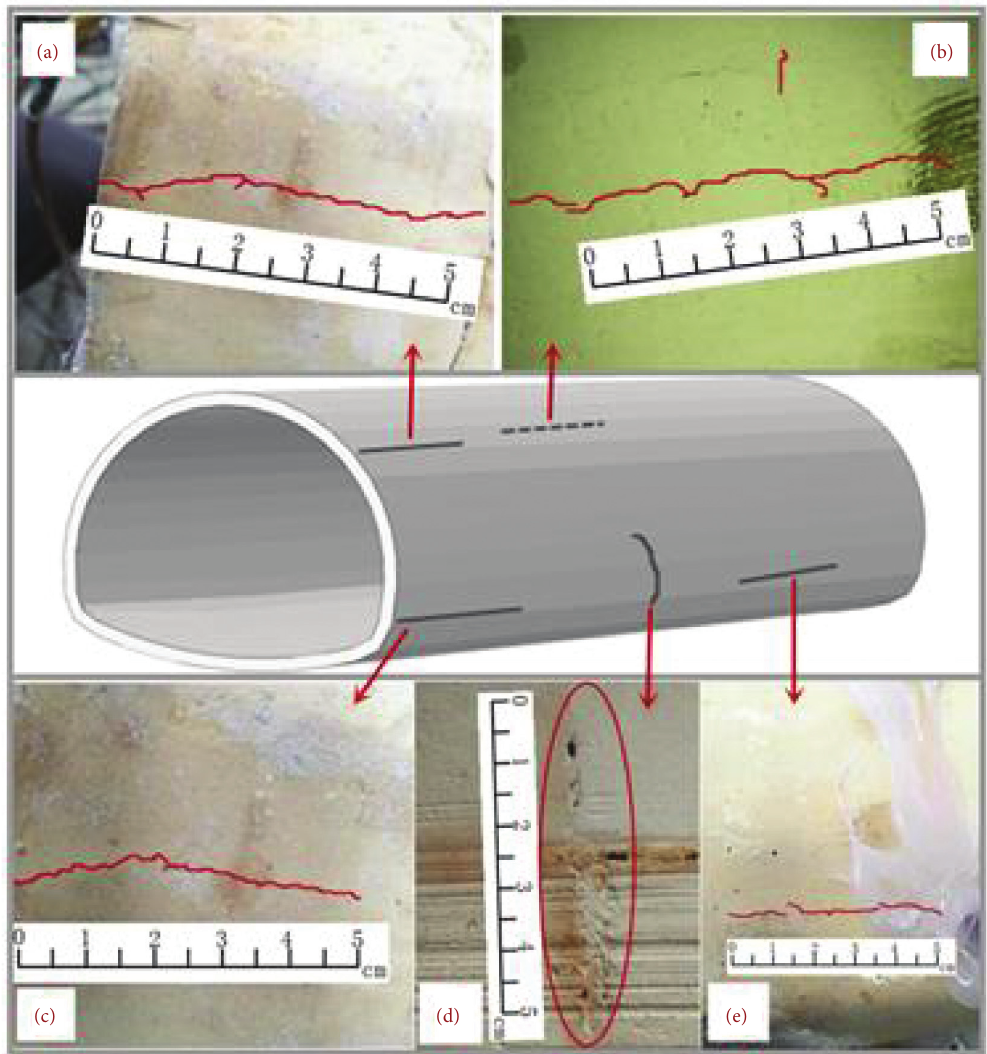
Figure 9: Lining crack. (a) Cracks in left skewback of bias section. (b) Cracks in right skewback of bias section. (c) Longitudinal cracks at right spandrel of portal section. (d) Ring crack of right spandrel in bias section. (e) Longitudinal crack of right spandrel in bias section.